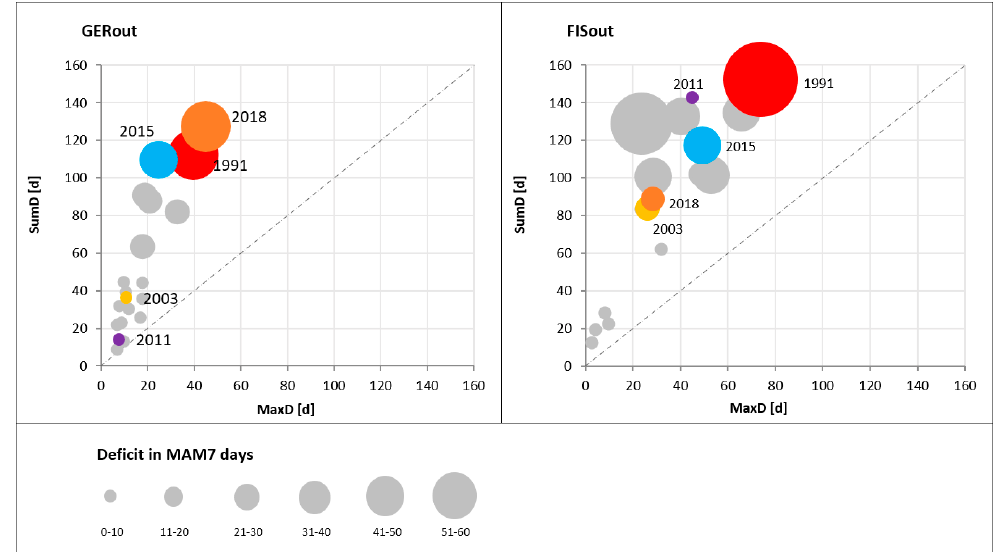
Figure 10. Scatterplot presenting SumD and MaxD values for the threshold MAM7 for each year of the study period 1980–2018: the size of each circle indicates the number of MAM7 days necessary to balance out the deficit of each year (scheme inspired by KLIWA [9]).